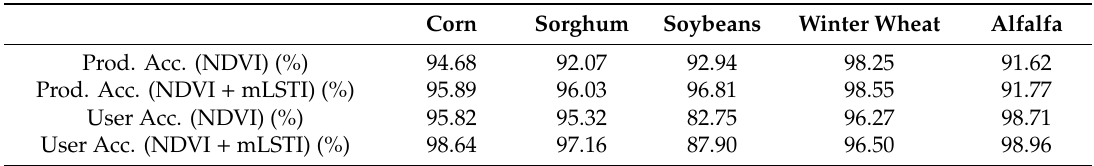
Table 6. Classification accuracies of di ff erent crops based on long time series.